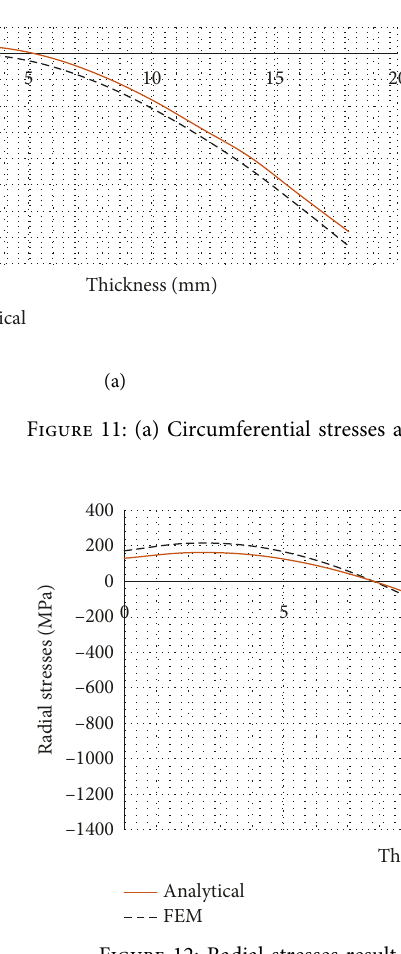
Figure 12: Radial stresses result by FEM and analytical approach.